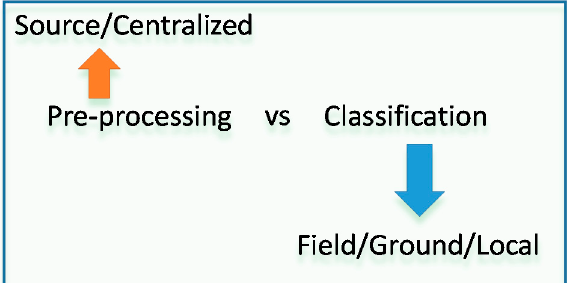
Figure 3. Conceptual framework of pre-processing and image classification showing centralized versus field/ground/local level processing .